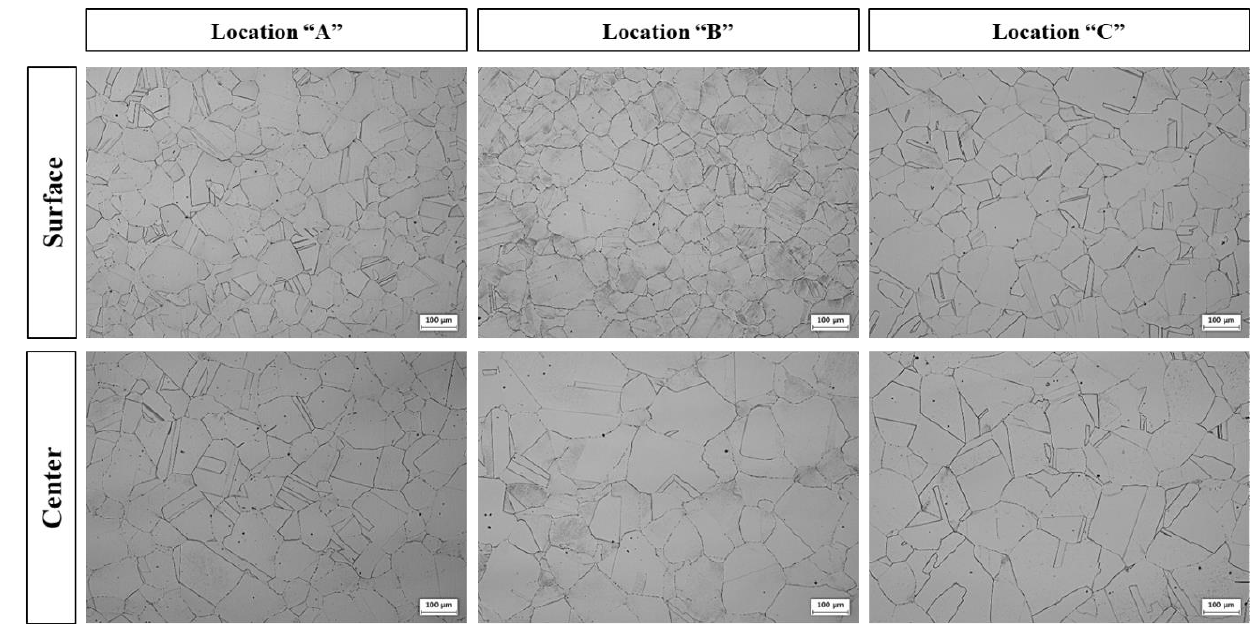
Figure 2. Optical micrograph showing the microstructures at each location of the as-rolled lightweight steel shown in Figure 1.